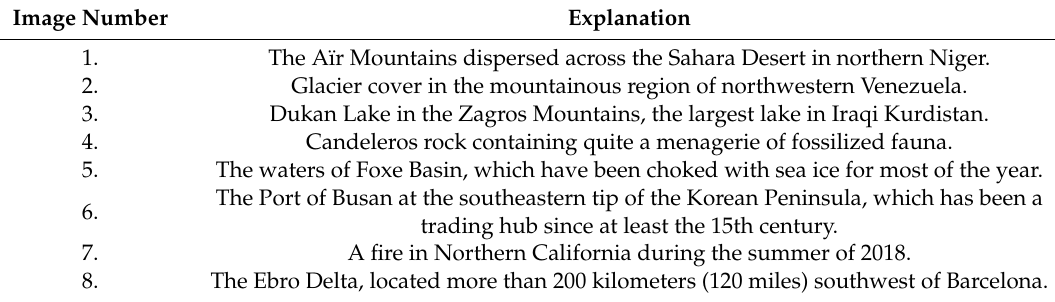
Table 2. Explanation of the satellite images.